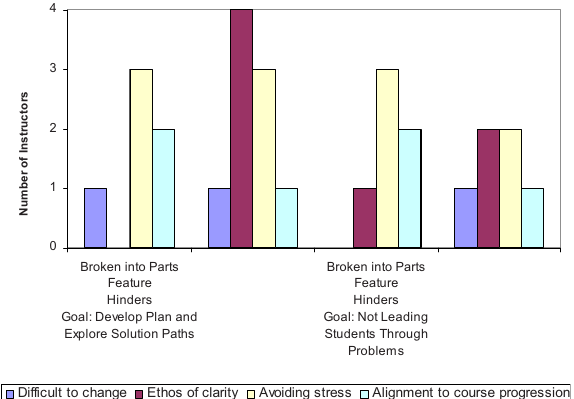
FIG. 12. (cid:1) Color (cid:2) Instructors’ reasons for using problem features they believe hinder